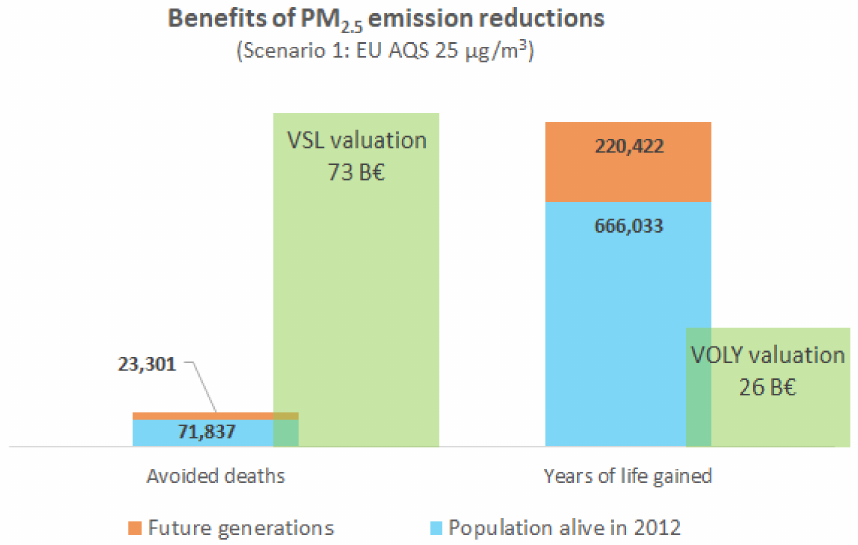
Figure 2. Scenario 1: cumulative mortality benefit of PM 2.5 emission reductions for the city of Skopje aggregated over a follow up period of 105 years.